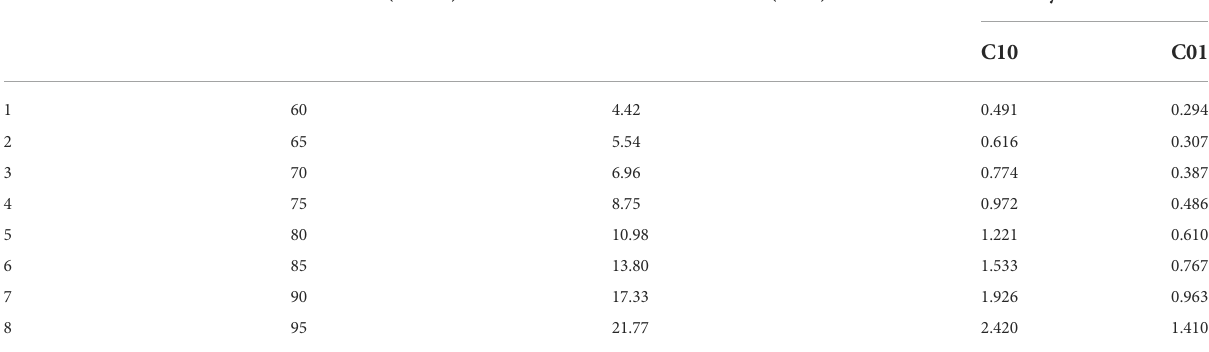
TABLE 4 Mechanical properties of rubber